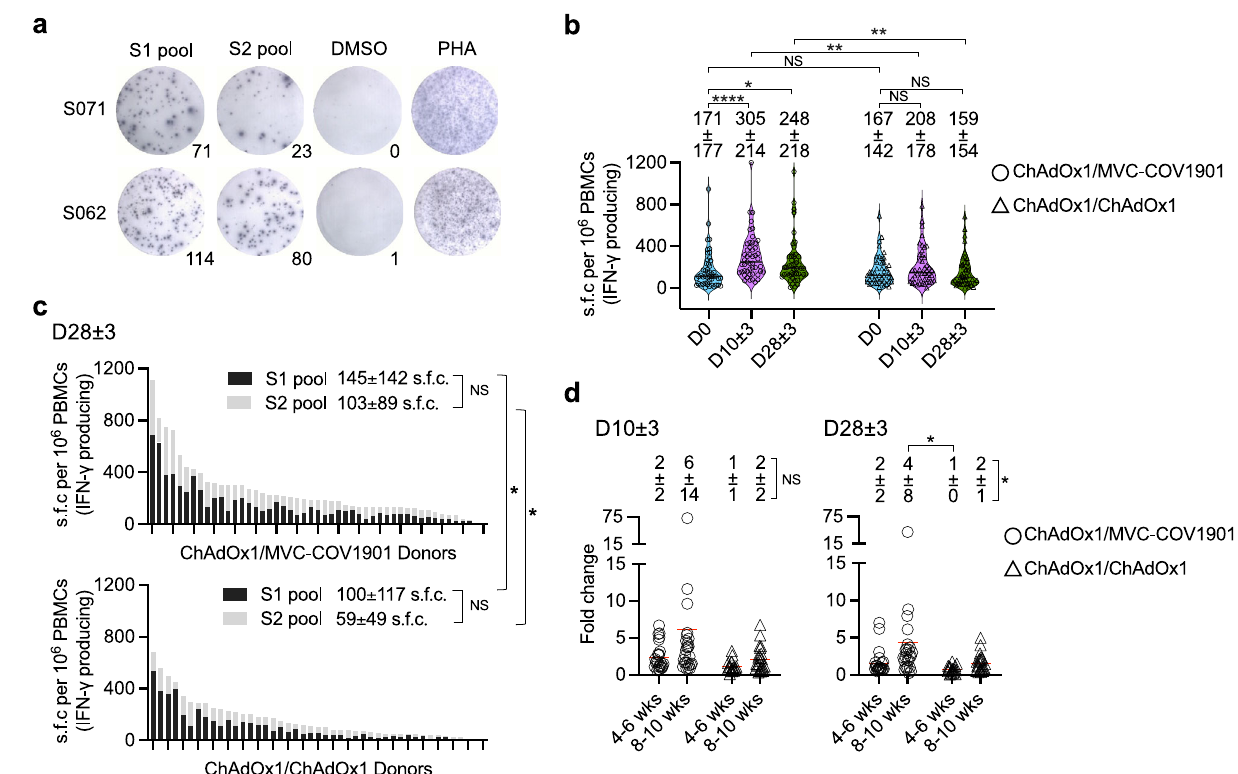
Fig.6|TcellresponsetoSARS-CoV-2spikeispresentinrecipientspriortoand after the booster dose. a Representative ELISpot from one ChAdOx1/MVC- COV1901 recipient (S062) and one ChAdOx1/ChAdOx1 recipient (S071) against spike (pools 1 and 2), with DMSO as negative control and PHA as positive control. b Totalspike-speci fi cT-cellresponses(sumofS1andS2subunitresponses,mean± standard deviation) prior to, at day 10±3, and day 28±3 after the booster dose in ChAdOx1/MVC-COV1901 ( n =49) and ChAdOx1/ChAdOx1 ( n =45) groups. Each point on violin plot represents a single recipient and black line represents the median. The signi fi cance was determined using one-way ANOVA with post hoc Dunn ’ stest.ChAdOx1/MVC-COV1901,Day0vsDay10±3, P <0.0001;Day0vsDay 28±3, P =0.0486.ChAdOx1/ChAdOx1,Day0vsDay10±3, P >0.9999;Day0vsDay 28±3, P >0.9999. The signi fi cance between two groups was determined using a Mann – Whitney test (two-tailed). Day 0, P =0.7022; Day 10±3, P =0.0039; Day 28±3, P =0.0053. c Summary data of day 28±3T cell response in vaccine